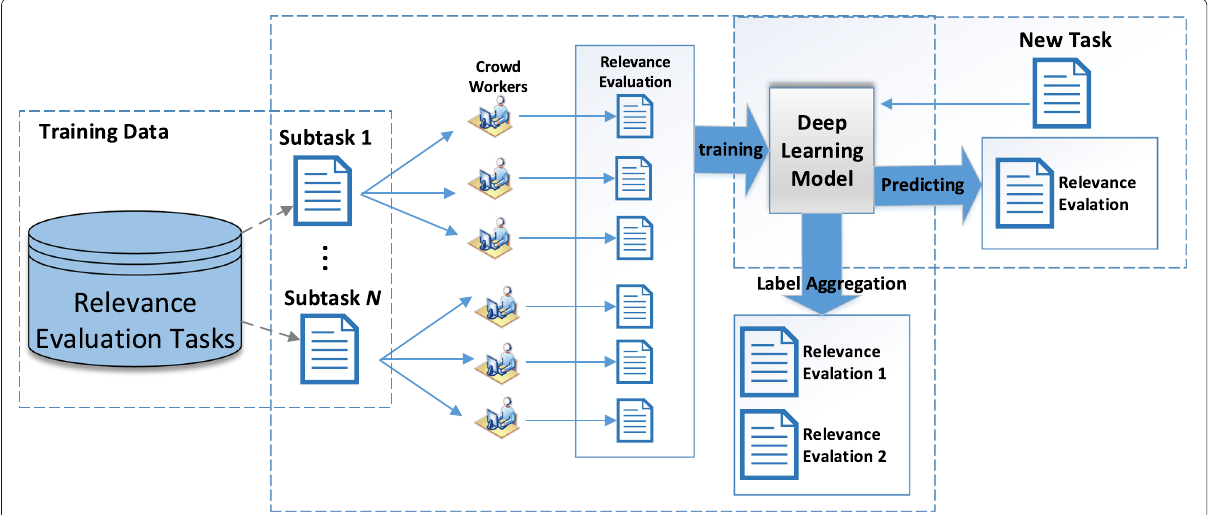
Fig. 2 The proposed framework. A framework of relevance evaluation with deep learning in